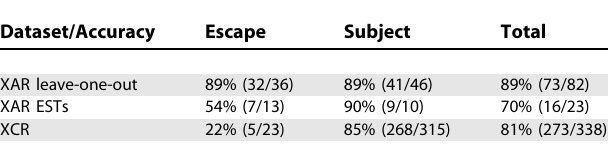
Table 3. Frequently Selected Features during 100 Independent Feature Selection Experiments Involving Random Subsets of XAR Nonborder Genes and Their Individual Classification Perform-